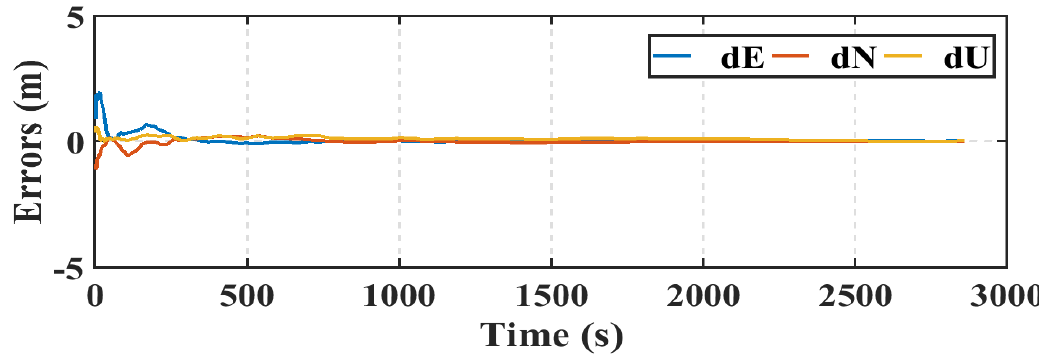
Figure 13. Geodetic receiver PPP solution errors in East, North, and Up directions (dE, dN, dU). Table 3. Mean and RMS for East, North, and Up components.